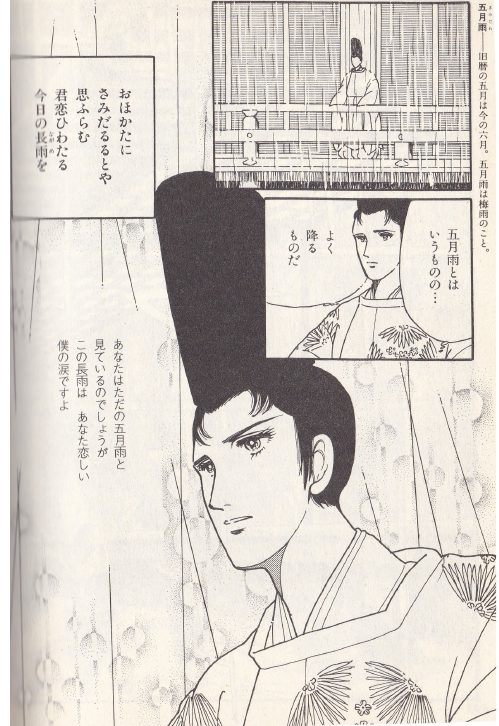
Figure 10. The Prince gazes out on a rainy day (Kosakabe and Tanaka, Manga Izumi Shikibu nikki , 1990), 108. Courtesy of